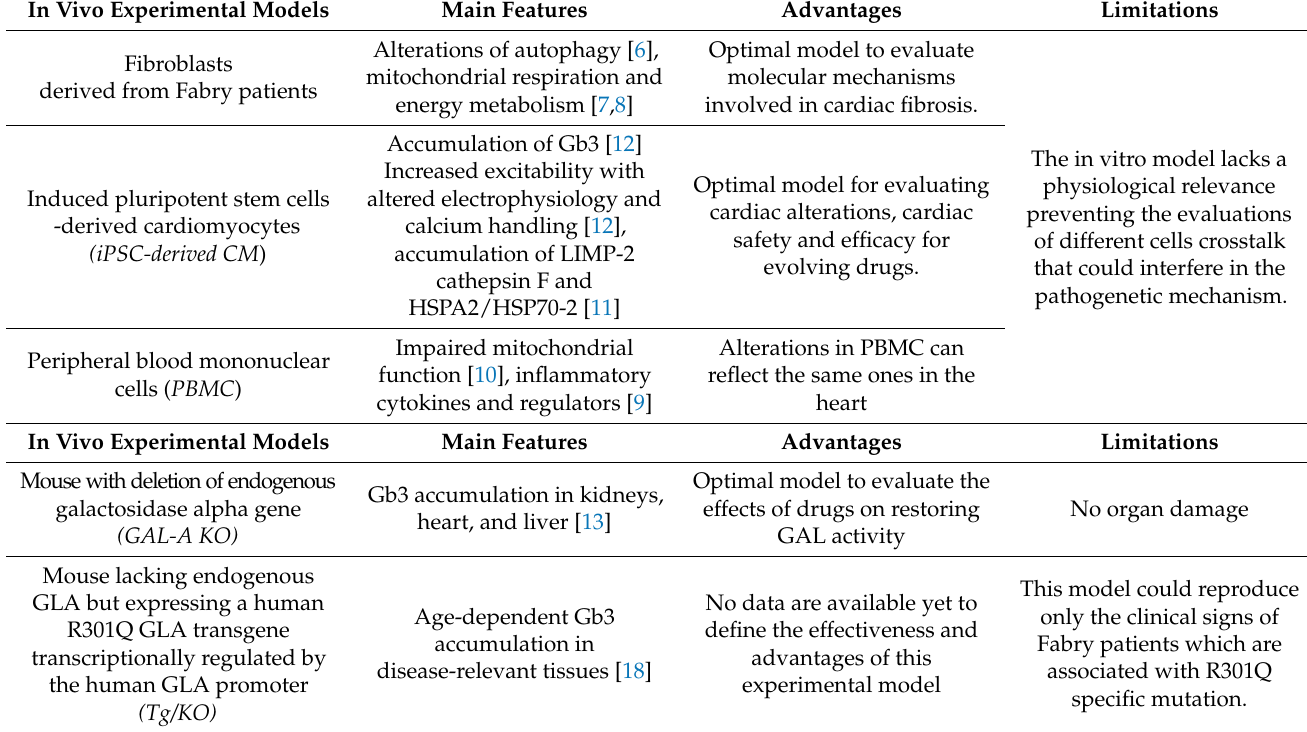
Figure 1. Fabry experimental models. The study of Fabry disease is performed in both cellular and animal models. Cells which are isolated from Fabry patients include fibroblasts, induced pluripotent stem cells (iPSCs)-derived cardiomyocyte (CM) and peripheral blood mononuclear cells (PBMC). Two in vivo animal models are available for studying the physiopathology of Fabry disease: Mice bearing a deletion of the endogenous galactosidase alpha gene (GAL-A KO) and mice lacking endogenous galactosidase alpha gene (GLA) but expressing a human R301Q GLA transgene transcriptionally regulated by the human GLA promoter (Tg/KO mice). Table 1. Main features of Fabry experimental